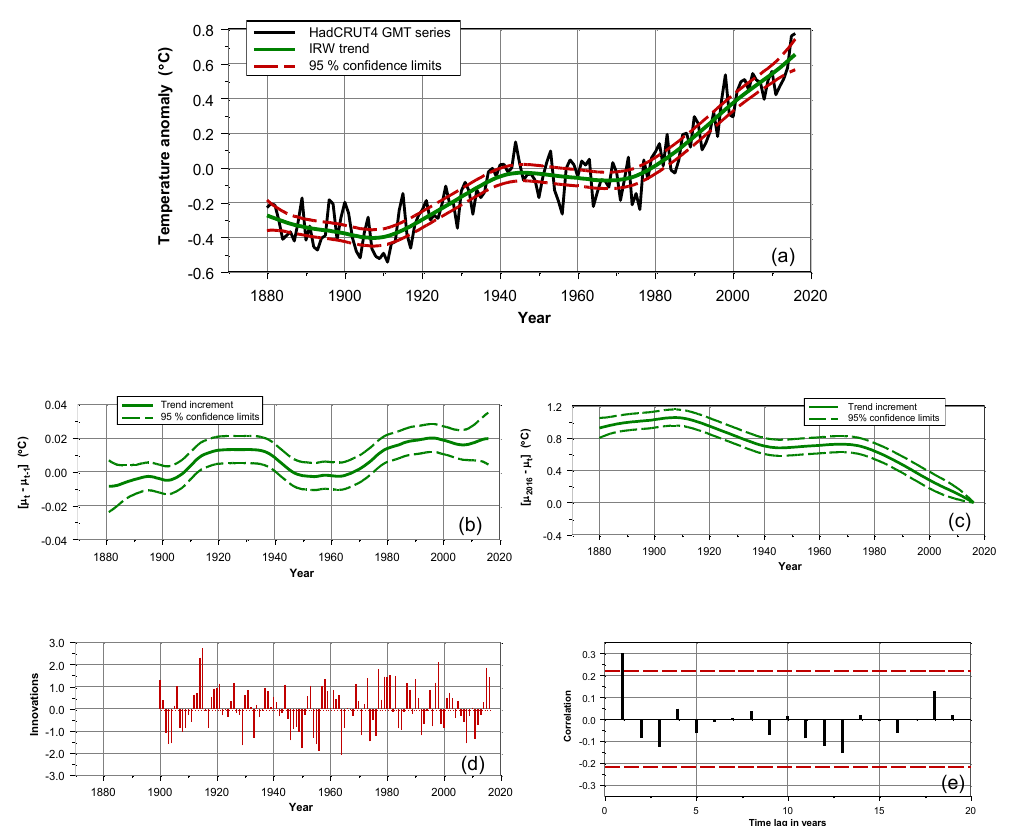
Figure 3. Results for the IRW trend model as applied to the HadCRUT4 series. Period: 1880–2016. Panel (a) shows the trend (green line) along with 95% confidence limits (red dashed lines). The trend increments [ µ t − µ t − 1 ] are given in (b) along with uncertainties. Idem the [ µ t − µ 1880 ] values in (c) . Panel (d) shows the innovations or one-step-ahead prediction errors which follow from the Kalman filter formulae. Panel (e) shows the autocorrelation function